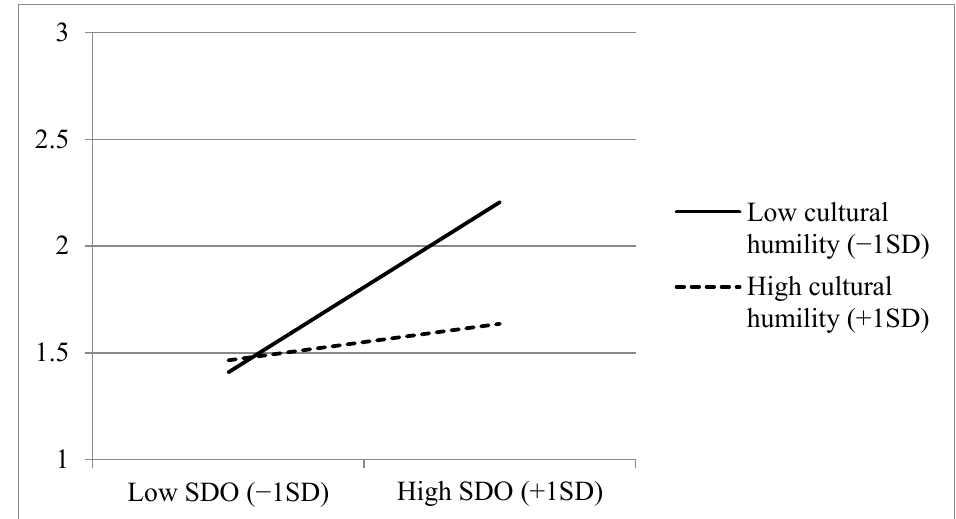
Figure 1. Prejudice as a function of social dominance orientation (SDO) and cultural humility .